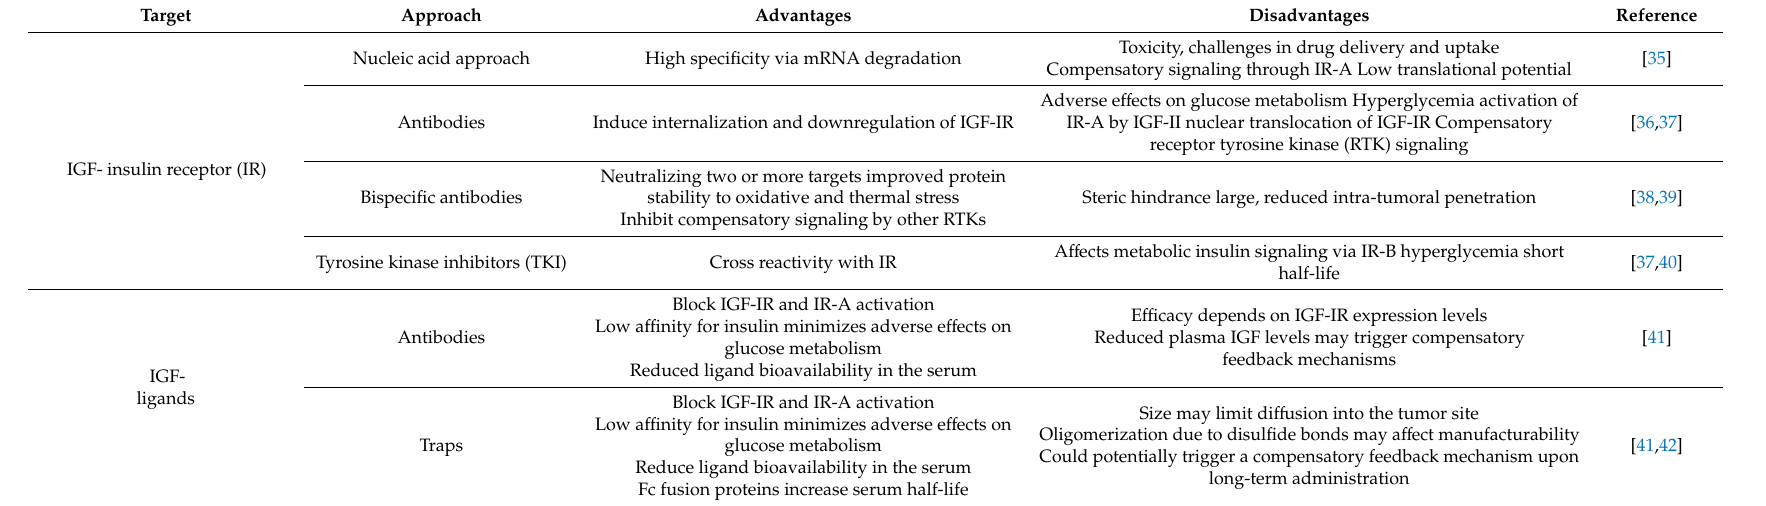
Table 1. Insulin-like growth factor (IGF) targeting strategies: the pre-clinical and clinical